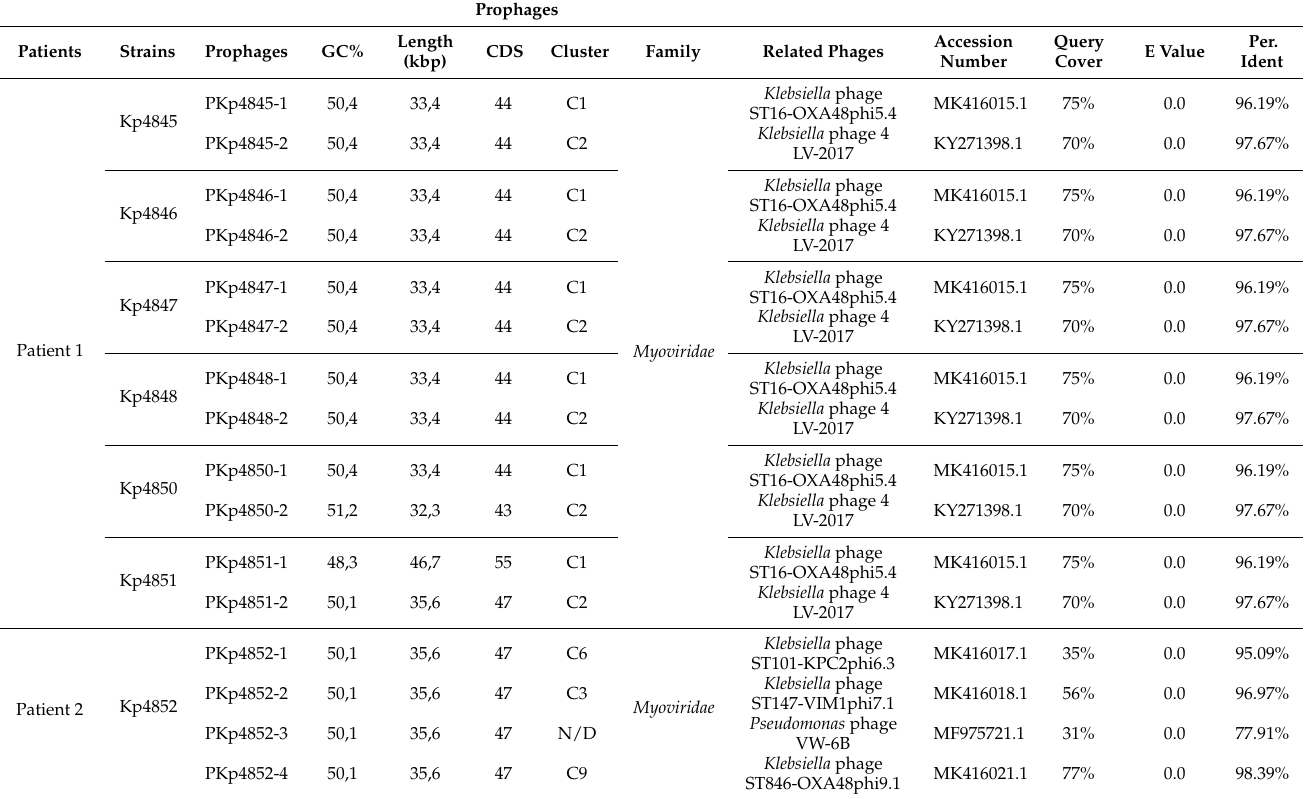
Table 1. Intact prophage genomes characterization. Features such as patient, GC%, length, CDS, cluster, family (in silico-determined) and most related-phage identified are shown for each prophage. GC, guanine–cytosine.